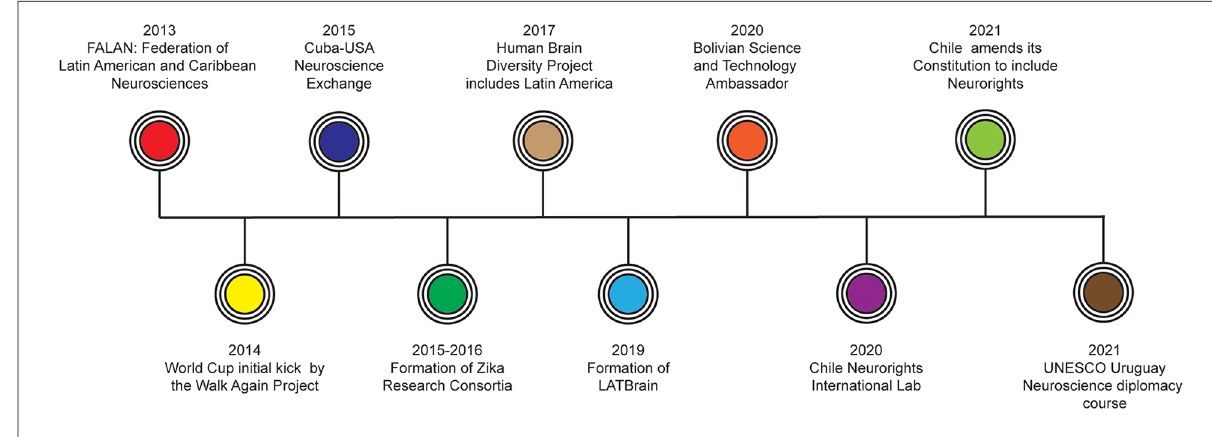
FIGURE 1 Major landmarks of neurodiplomacy and neuroscience initiatives in Latin